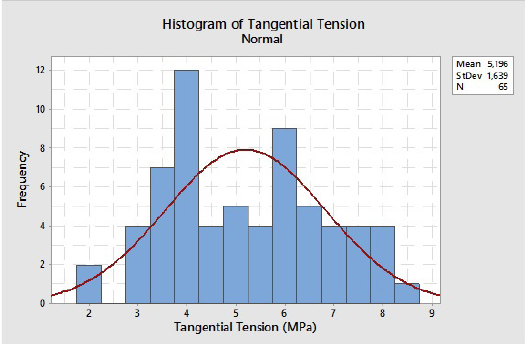
Figure 7. Histogram of Tangential Tension Strength.